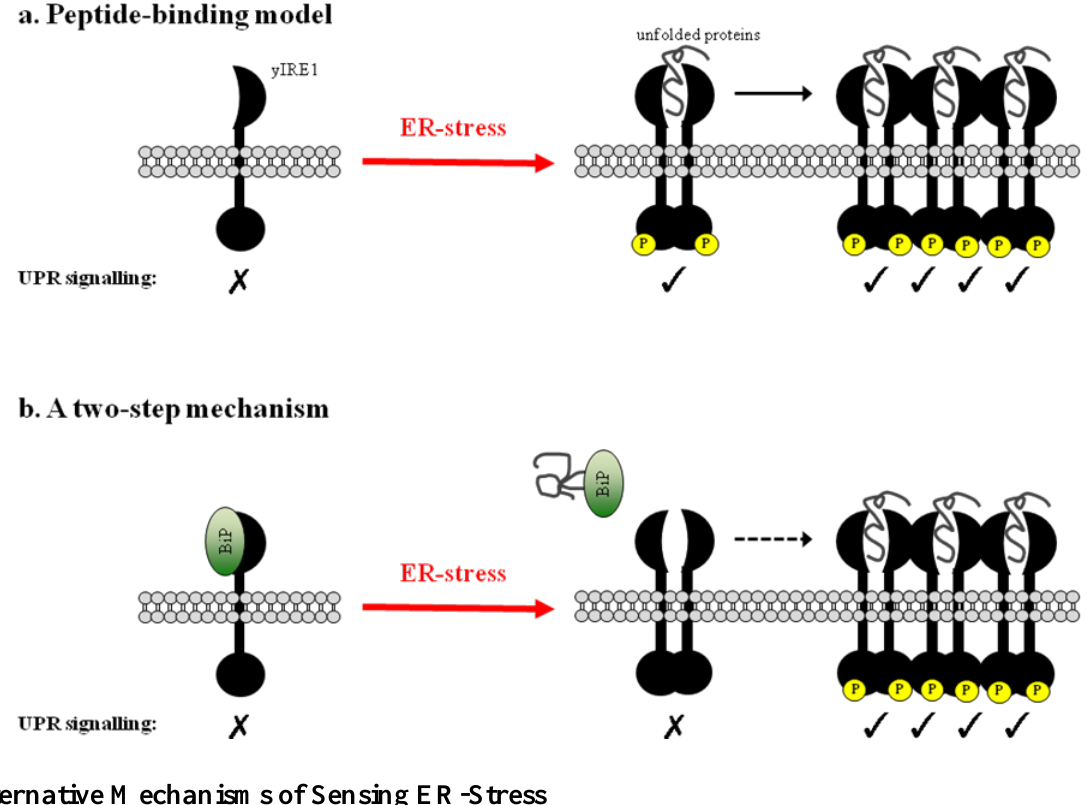
Figure 3. A direct role for unfolded proteins in UPR activation. ( a ) The peptide-binding model: in the absence of ER-stress, monomeric yIRE1 is incompetent for UPR signaling. During ER-stress, the unfolded proteins in the ER lumen bind at the dimerization interface of yIRE1 sensor domain allowing its activation. Peptide binding then leads to the formation of highly active yIRE1 clusters via a secondary interface; ( b ) A two-step mechanism: in this model the dissociation of BiP from the monomeric and inactive yIRE1 sensor domain allows for spontaneous dimer formation. Subsequently, the direct binding of the unfolded proteins at the dimerization interface and yIRE1 clustering activates UPR